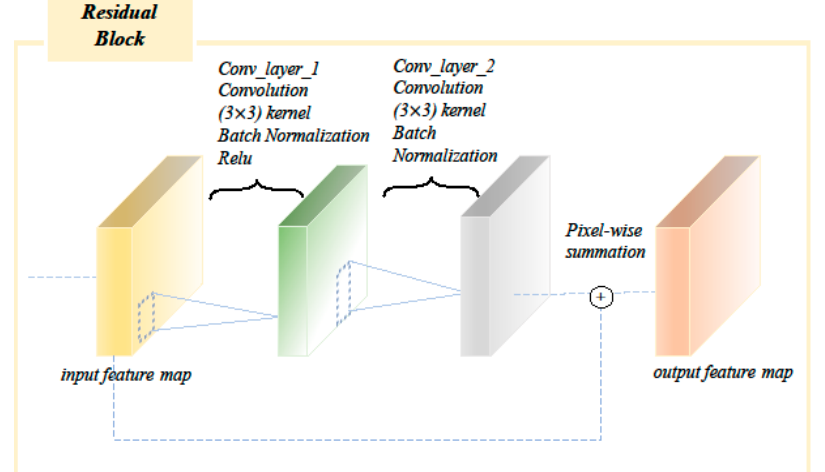
Figure 4. Residual block structure in the network. The residual block consisted of two 3 × 3 convolution layers and a batch normalization layer.